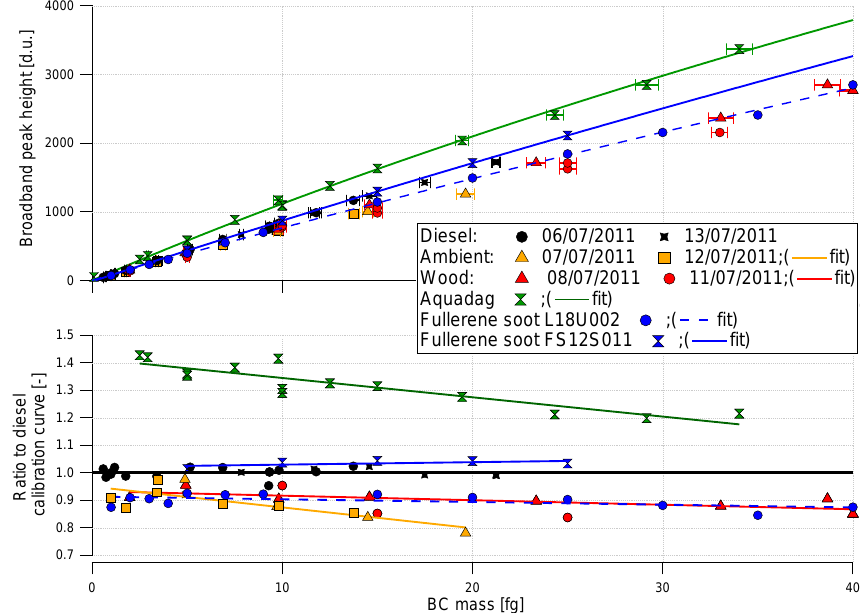
Fig. 5. Sensitivity of the SP2 to different BC types. (a) Calibration curves and (b) ratio to the diesel exhaust calibration. By definition, the diesel calibration is unity. Note: the calibration curve of BC from ambient aerosol is most likely biased towards too high mass values, as the selected particles were not 100% pure rBC. The errors bars represent one standard deviation of the mass